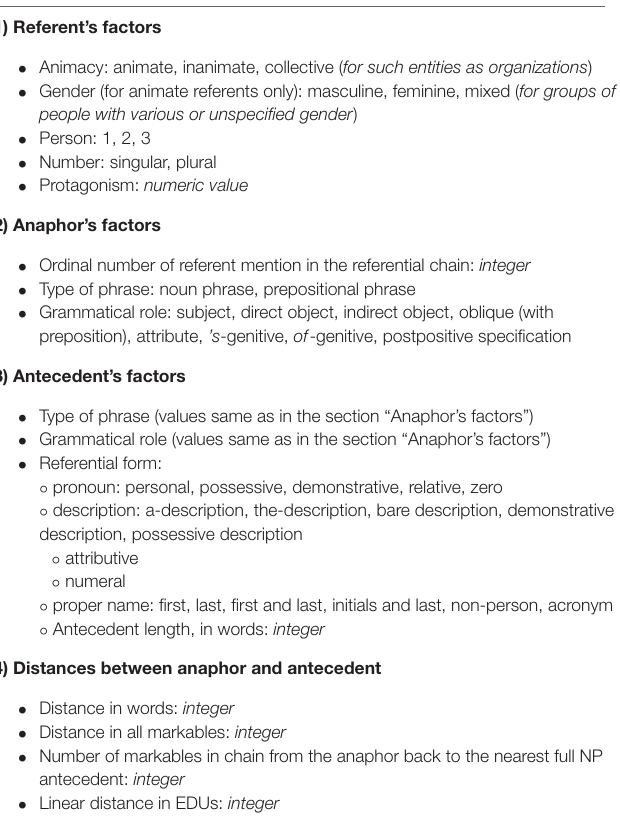
TABLE 4 | Candidate factors of referential